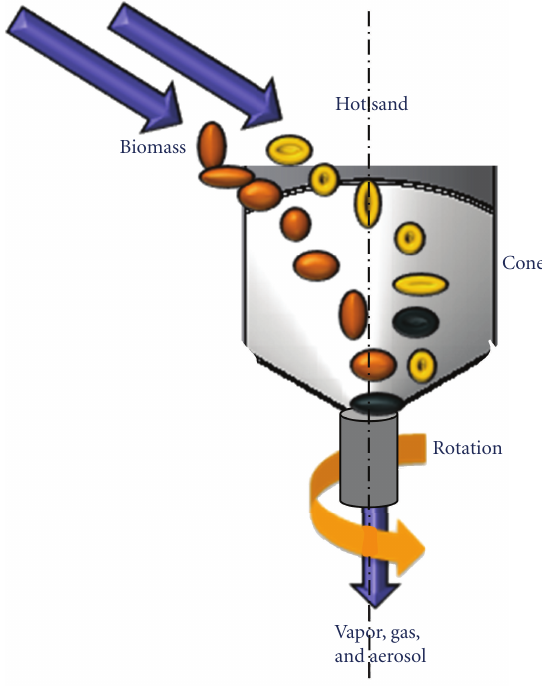
Figure 5: Rotating cone